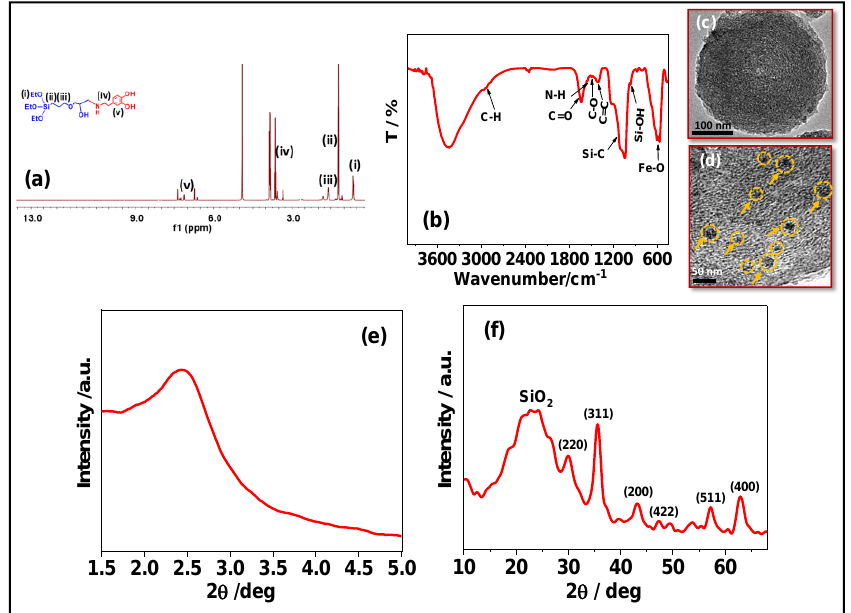
Figure 1. ( a ) 1 H NMR spectrum of DS precursor; ( b ) FTIR spectrum; ( c , d ) TEM images and the yellow circles indicate the presence of magnetic iron oxide nanoparticles; ( e , f ) low and higher angle XRD spectra of the FeNP@MSHC